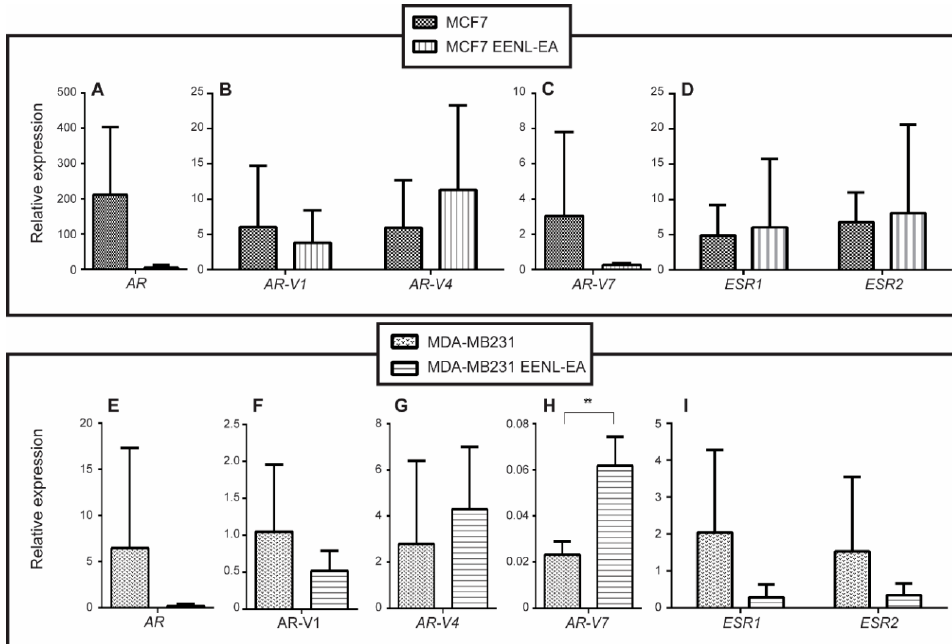
Figure 3. Relative expression of hormone receptors transcripts after treatment with Ethanolic Extract of Neem Leaves (EENL). Cell lines were treated with 1.0 μ g/mL of EENL obtained with ethyl acetate (EENL–EA) for 48 h. Relative gene expression levels were evaluated for AR ( A ), AR-V1 ,